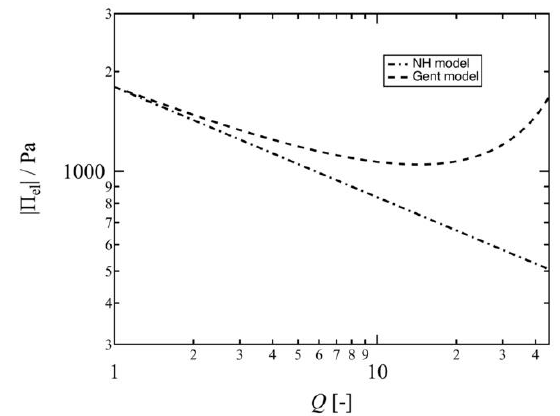
Figure 7. Swelling ratio ( Q ) dependence of the elastic pressure (| Π el |) of the 10 K Tetra-PAA-PEG gel. The dashed-dotted-dashed line represents | Π el | predicted by the Neo–Hookean model, while the dashed line represents | Π el | predicted by the Gent model.